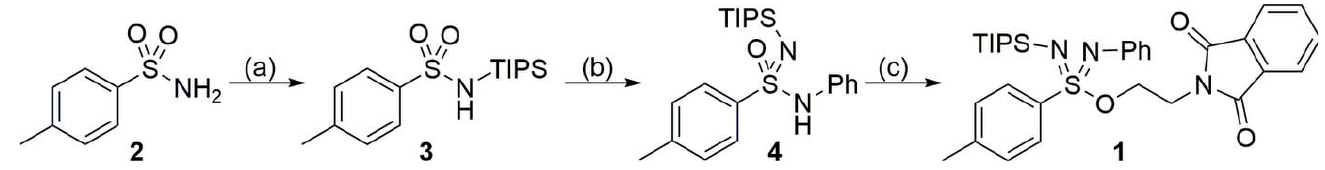
Figure 3 Synthesis of the sulfondiimidoate 1 . ( a ) TIPS-Cl, NEt 3 ; ( b) C 2 Cl 6 , PPh 3 , NEt 3 , aniline; ( c ) C 2 Cl 6 , PPh 3 , NEt 3 , N